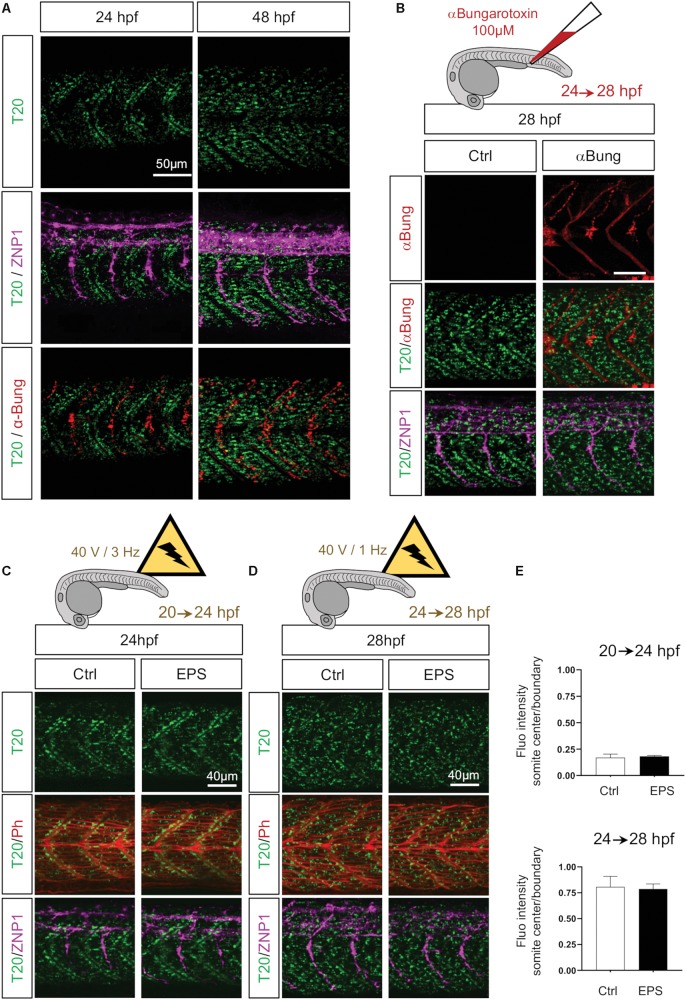
Neuronal stimulation and muscle contractions do not mediate mitochondrial patterning. (A) Confocal imaging of mitochondrial network (Tomm20, T20; green) counterstained with a marker for neuromuscular junctions αBungarotoxin (αBung; red) and a marker for primary motor neurons (ZNP1; magenta) at 24 and 48 hpf. While T20 signal corresponds to a unique confocal stack, αBung and ZNP1 represent the Z project. (B) Confocal imaging of mitochondrial network (Tomm20, T20; green) counterstained with αBungarotoxin (αBung; red) and primary motor neurons (ZNP1; magenta) at 28 hpf, with or without intravenous injection of αBungarotoxin performed at 24 hpf. (C) Confocal imaging of mitochondrial network (Tomm20, T20; green) counterstained with Phalloidin (Ph; red) at 24 hpf, with or without electrical pulse stimulation (EPS) applied at 20 hpf. (D) Confocal imaging of mitochondrial network (Tomm20, T20; green) counterstained with Phalloidin (Phall; red) at 28 hpf, with or without electrical pulse stimulation (EPS) applied at 24 hpf. (E) Quantification of Tomm20-zsGreen fluorescence ratio between somite center and boundary region at 24 and 28 hpf after 4 h of EPS (n = 6 fish per group, 3 images analyzed per fish).